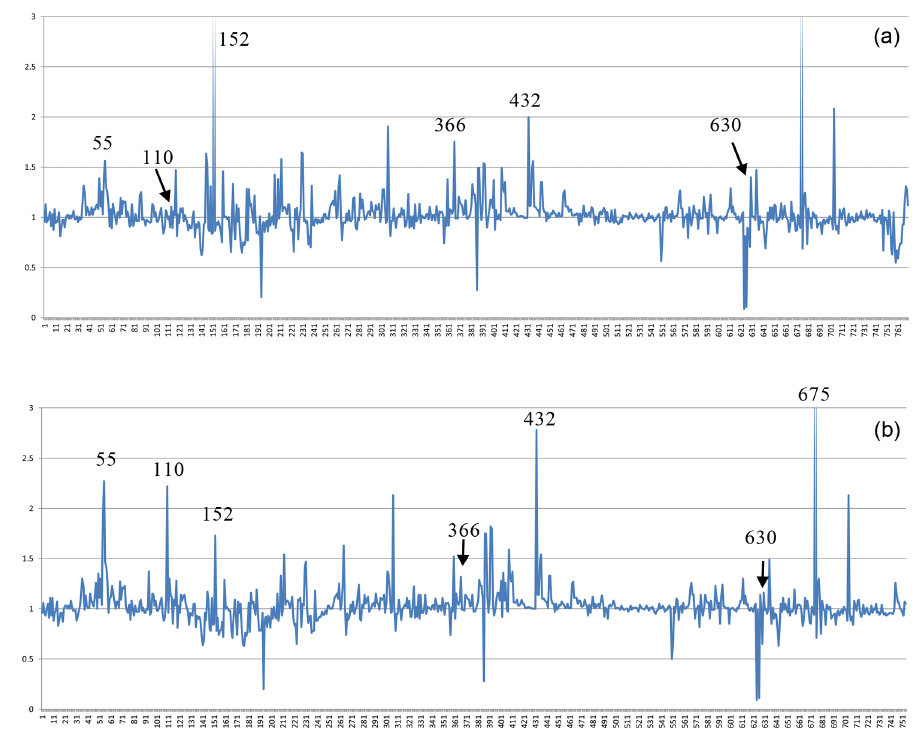
Figure 4. Plot of factors relating calculated to observed amount of H 2 O in non-zeolitic minerals. The sequence from left to right follows the sequence of entries in Table S1.